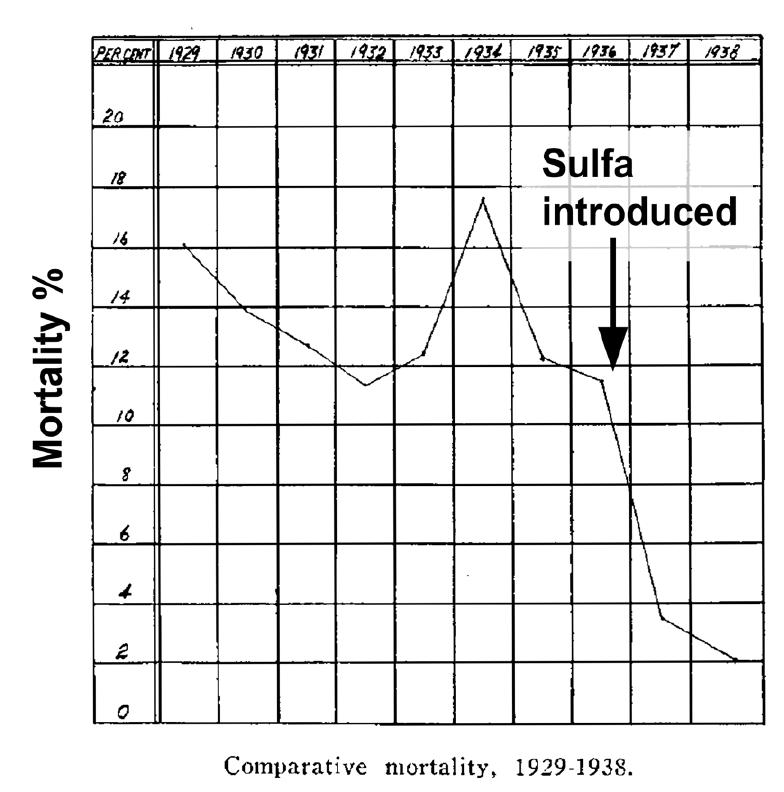
Figure 1. Mortality from Erysipelas Before and After the Introduction of Sulfonamide Antibiotic